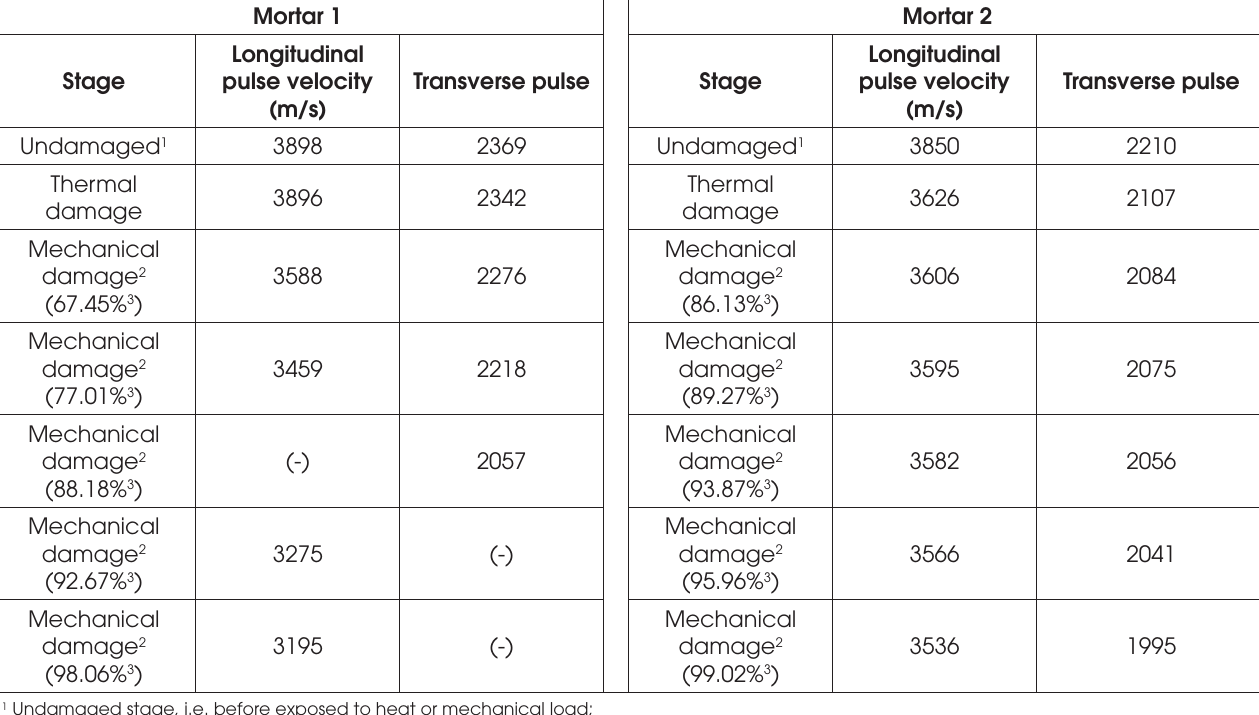
Ultrasonic wave velocities measured during the experiments Mortar 1 Mortar